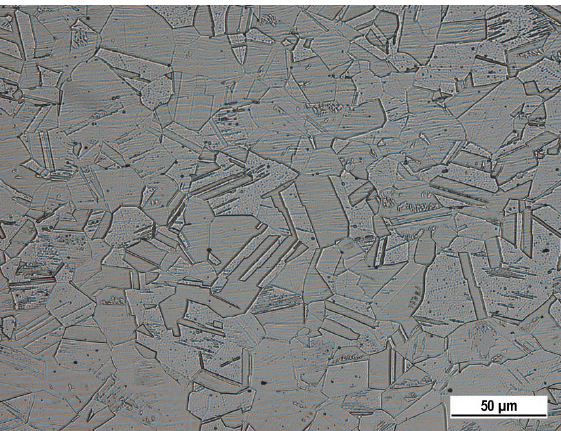
Figure 1. Microstructure of AISI 304 SS, longitudinal section (glycerine + HNO 3 + HCl etch., OM, magnification 500× ). Table 2. Conditions of the electrochemical etching (ASTM A262, A practice).